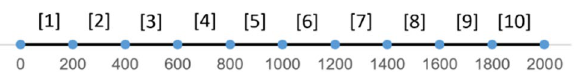
Fig. 1 Occurrence classes in the mentioned example (with a mini- mum of 0 and a maximum of 2000 occurrences per